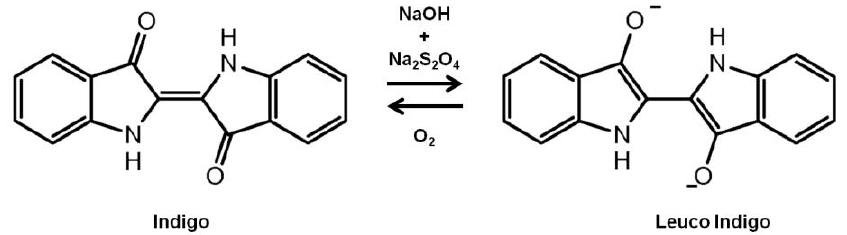
Figure 1. Chemical structure of indigo dye and its leuco